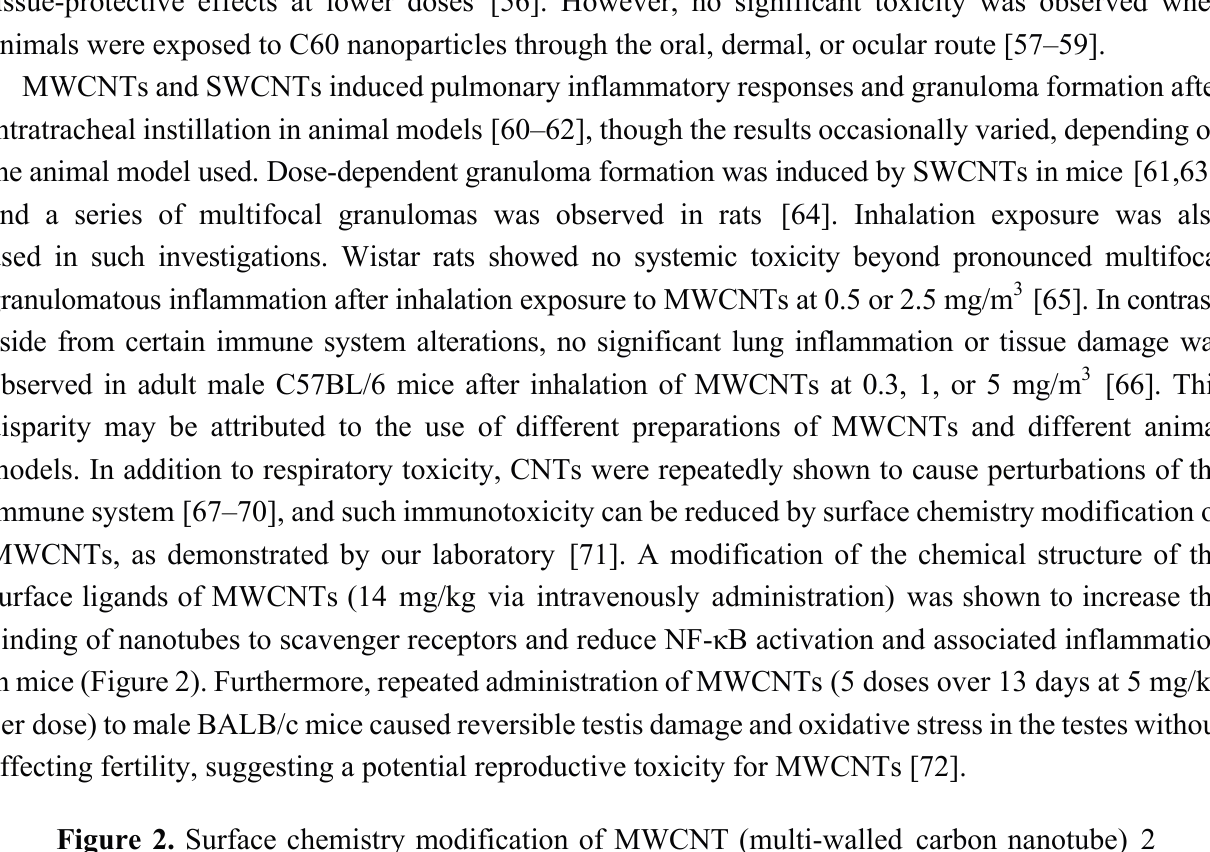
Figure 2. Surface chemistry modification of MWCNT (multi-walled carbon nanotube)